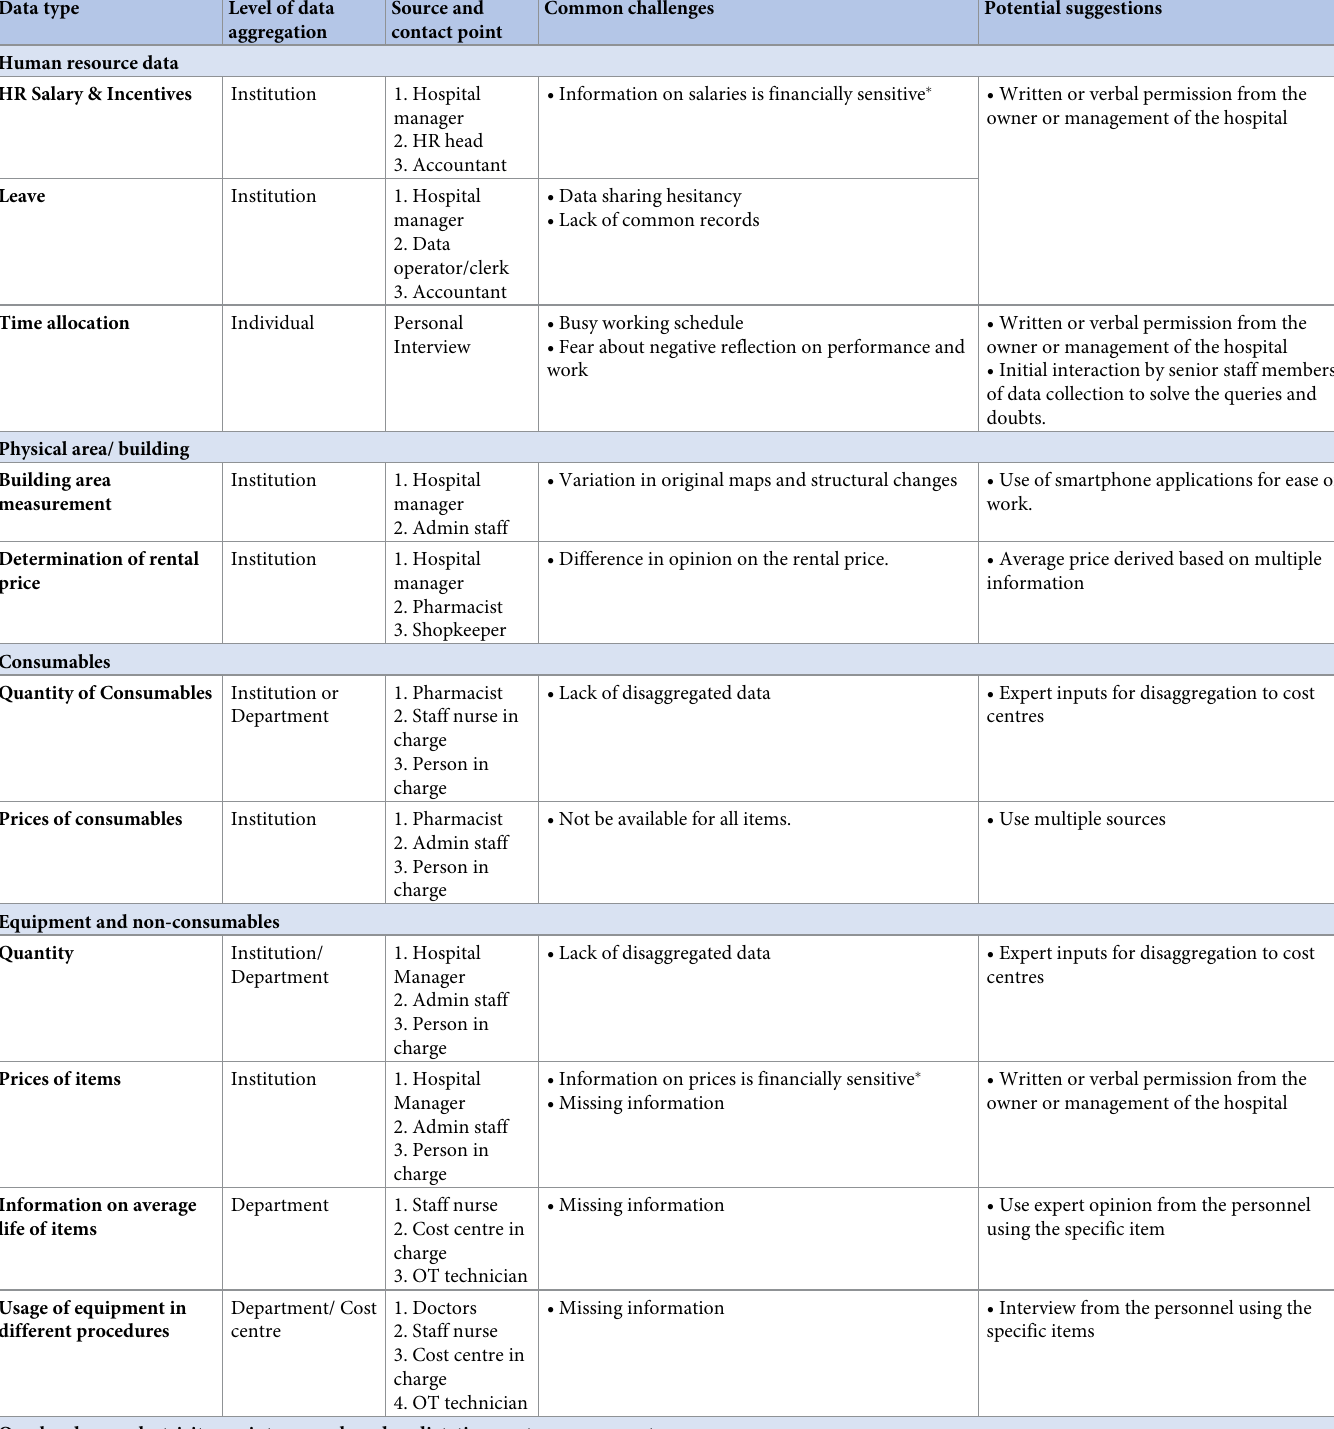
Table 2. Sources, challenges and potential solutions for cost data